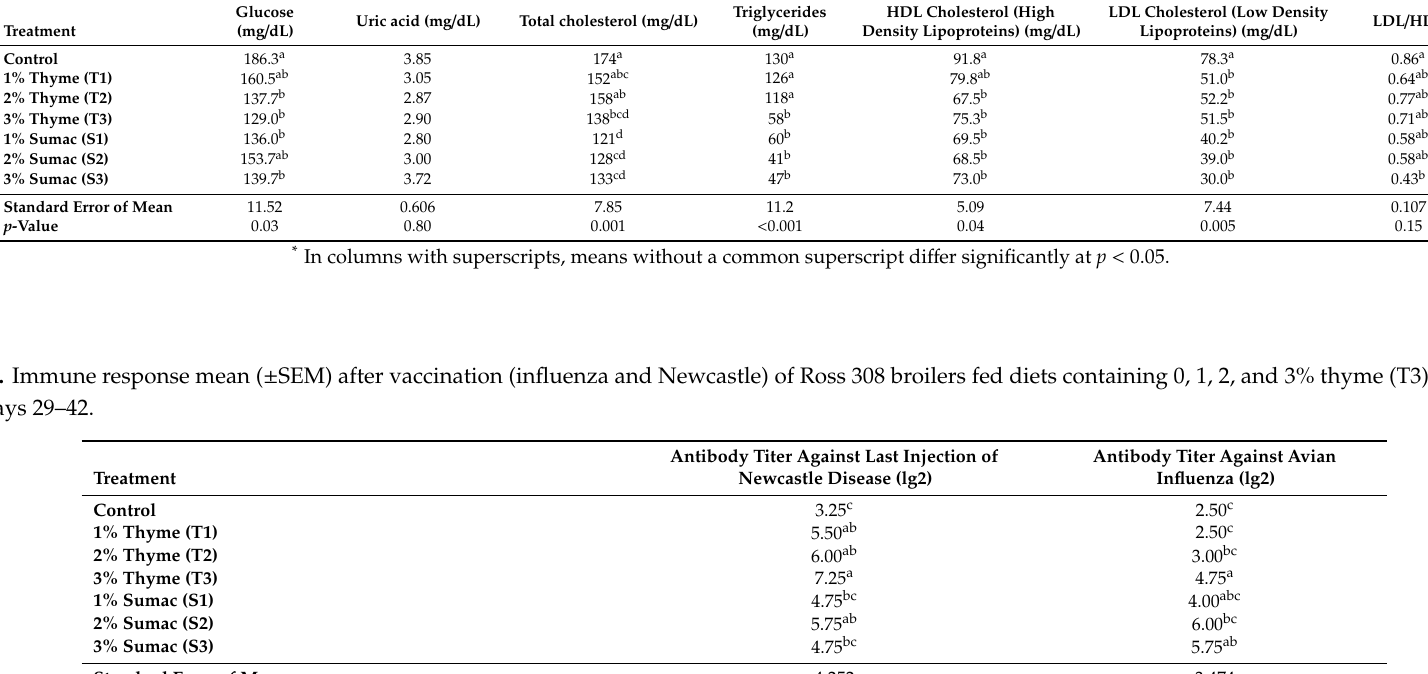
* In columns with superscripts, means without a common superscript di ff er significantly at p <